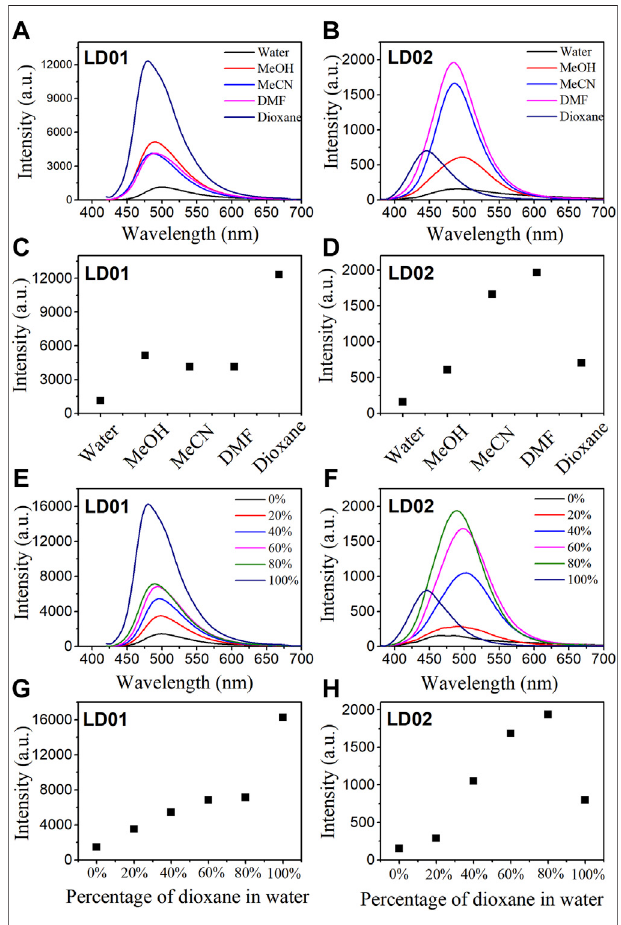
FIGURE2| FluorescencespectraofLD01( λ ex =410 nm)andLD02( λ ex = 365 nm) in different solvents (A, B) and in mixed solvents of dioxane and water (E, F) . Scatterplots of the most intense fl uorescence emission by LD01 (C, G) and LD02 (D, H) in (A, B, E, and F) , respectively.